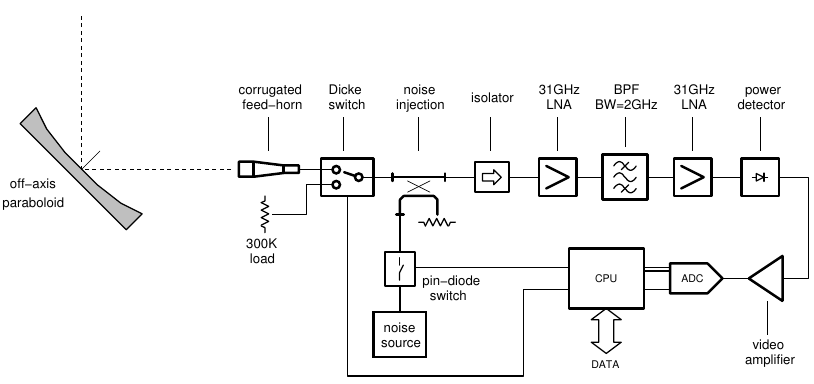
Figure 2. Schematic of the millimeter-wave radiometer module: a direct amplification architecture is assumed. The receiver gain is calibrated by noise injection, whereas the radiometer offset is calibrated using a reference load, working as a black-body, and a Dicke switch. Acronyms: Low Noise Amplifier (LNA); Band-Pass Filter (BPF); Bandwidth (BW); Analog-to-Digital Converter (ADC); Central Processing Unit